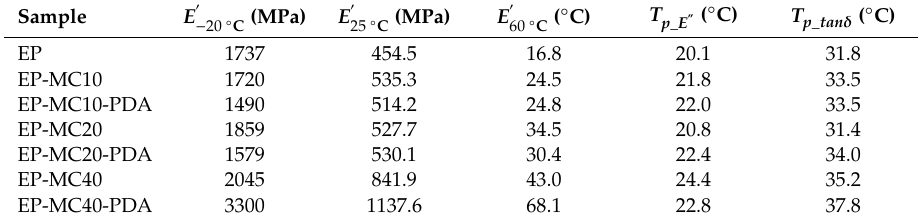
Figure 6. Results of dynamic mechanical thermal analysis (DMTA) tests. ( A ) Storage modulus ( 𝐸’ ), loss modulus ( 𝐸’’ ), and tan δ as a function of temperature for some selected compositions (EP, EP-MC20, and EP-MC20-PDA). ( B ) Detail of storage modulus in logarithmic scale. ( C ) Detail of loss modulus in logarithmic scale. Table 4. Main results of DMTA tests on the prepared composites.